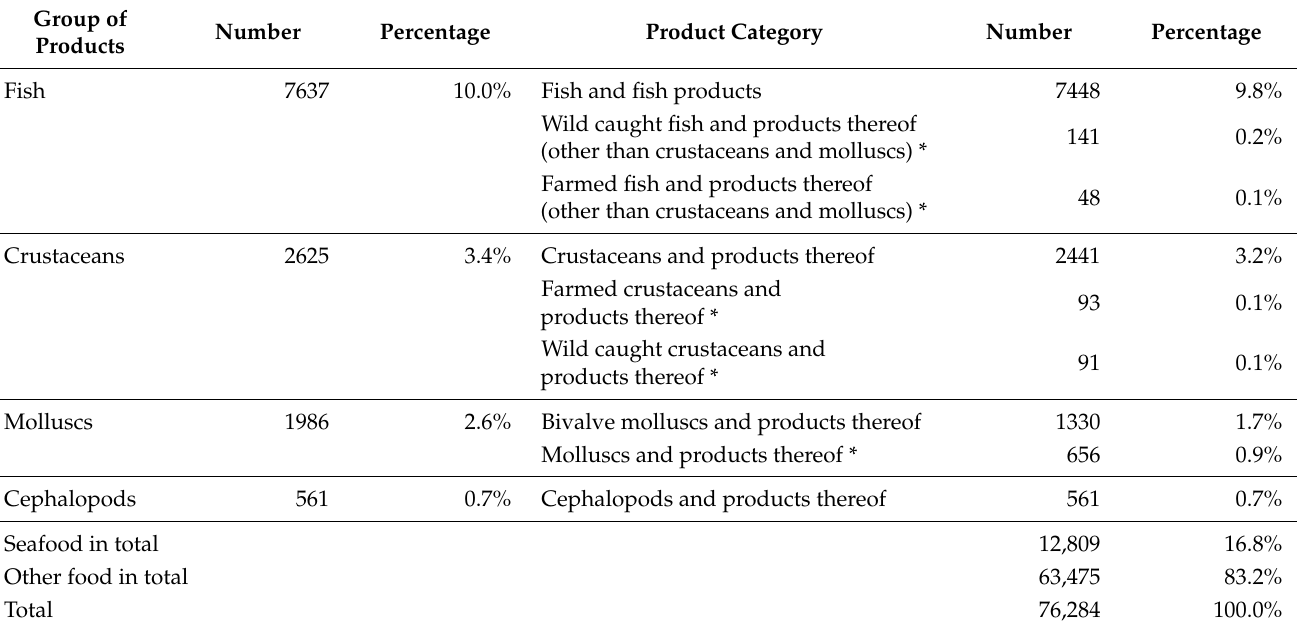
Table 1. The number of notifications and their percentage for seafood groups and product categories reported in the RASFF in